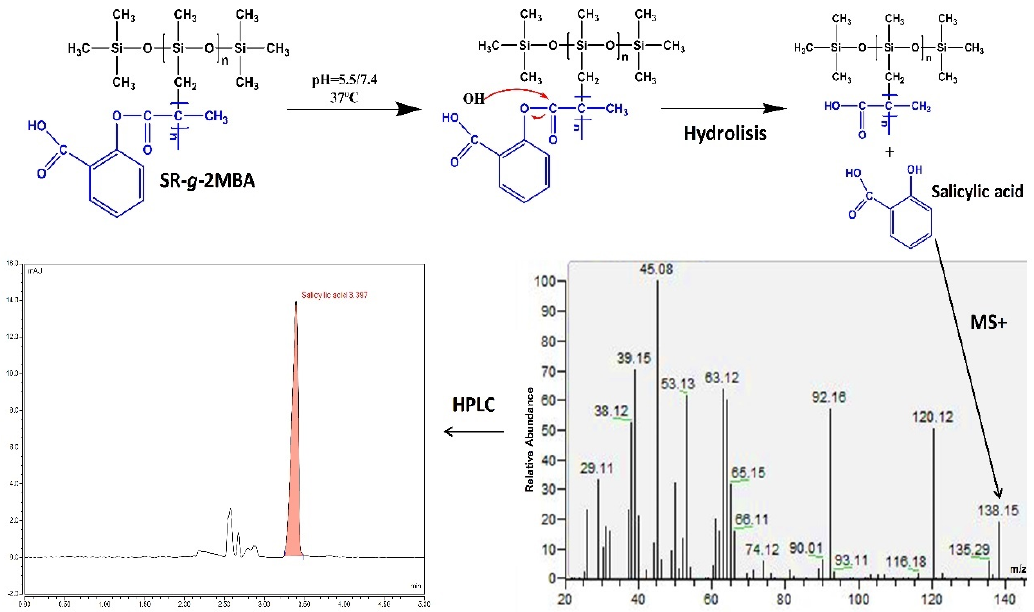
Figure 4. Schematic representation of SR- g -2MBA hydrolysis and salicylic acid release, molecular ion detection, and high-performance liquid chromatography (HPLC) quantification. Polymers 2020 , 12 , x FOR PEER REVIEW